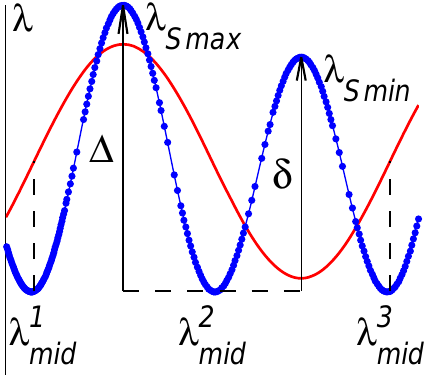
/1 S (see text); smoothed ar- max min , and local minima λ i . Black lines mid min and δ S max min